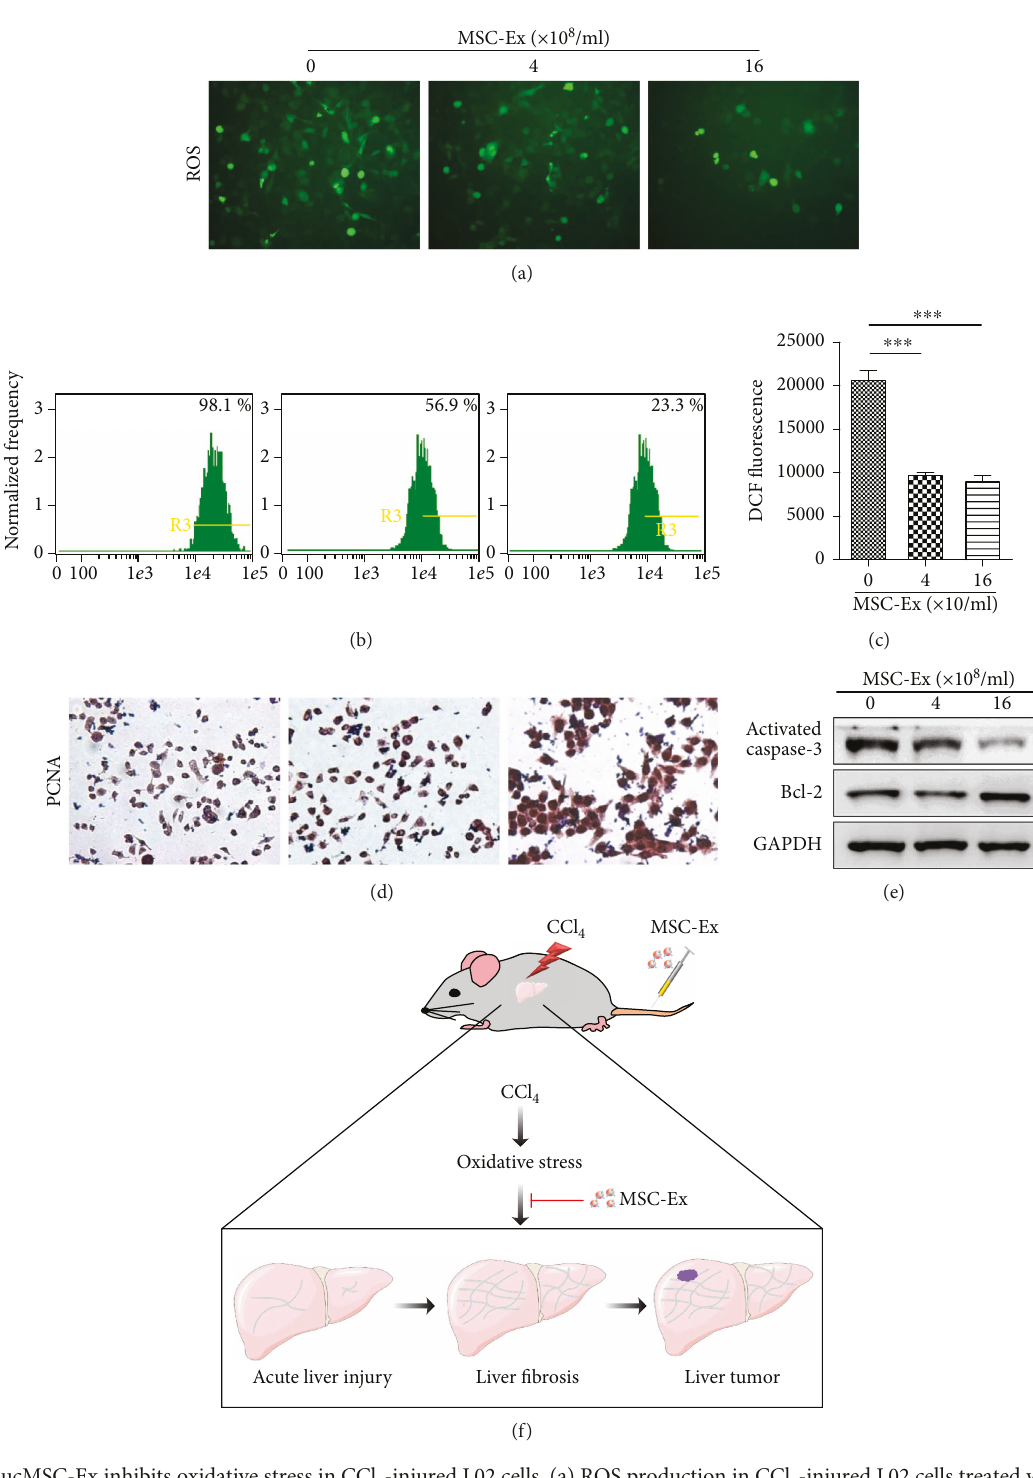
Figure 6: hucMSC-Ex inhibits oxidative stress in CCl -injured L02 cells. (a) ROS production in CCl -injured L02 cells treated with di ff erent 4 4 doses of hucMSC-Ex (0 particles/ml, 4 × 10 8 particles/ml, and 16 × 10 8 particles/ml). Original magni fi cation 200x. (b) Percentage of DCF- positive hepatocytes in hucMSC-Ex treated L02 cells using imaging fl ow cytometer. Data showed that hucMSC-Ex signi fi cantly decreased percentage of DCF-positive hepatocytes. (c) Fluorescence intensity of DCF-positive L02 cells was signi fi cantly decreased by hucMSC-Ex treatment. DCF fl uorescent values are means ± SD. ( n = 3 ; ∗∗∗ P < 0 001 ). (d) Immunohistochemistry staining of PCNA in hucMSC-Ex- treated L02 cells. Percentage of PCNA-positive L02 cells and PCNA expression was enhanced in the hucMSC-Ex group compared with that in the PBS group. Original magni fi cation 200x. (e) Western blot quanti fi cation of activated caspase 3 and Bcl2. hucMSC-Ex induced Bcl2 expression and inhibited activated caspase 3 expression in CCl -injured L02 cells. (f) Experimental model design of hucMSC-Ex in 4 -induced liver tumor CCl 4